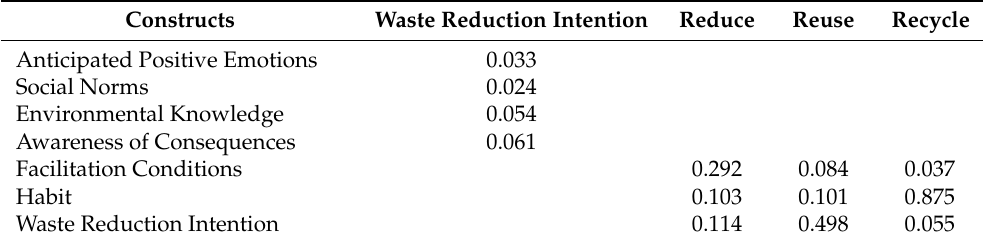
Table 6. Effect size (f 2 ).